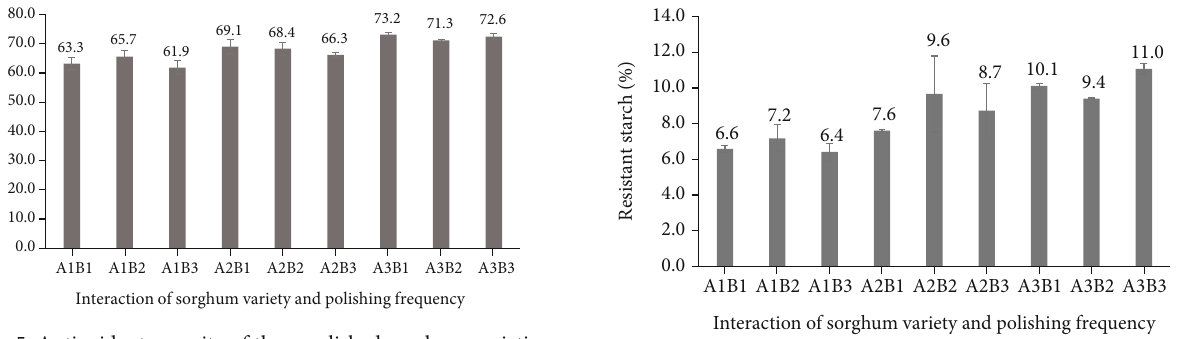
Figure 8: Resistant starch (%) in polished sorghum grains at di ff erent polishing